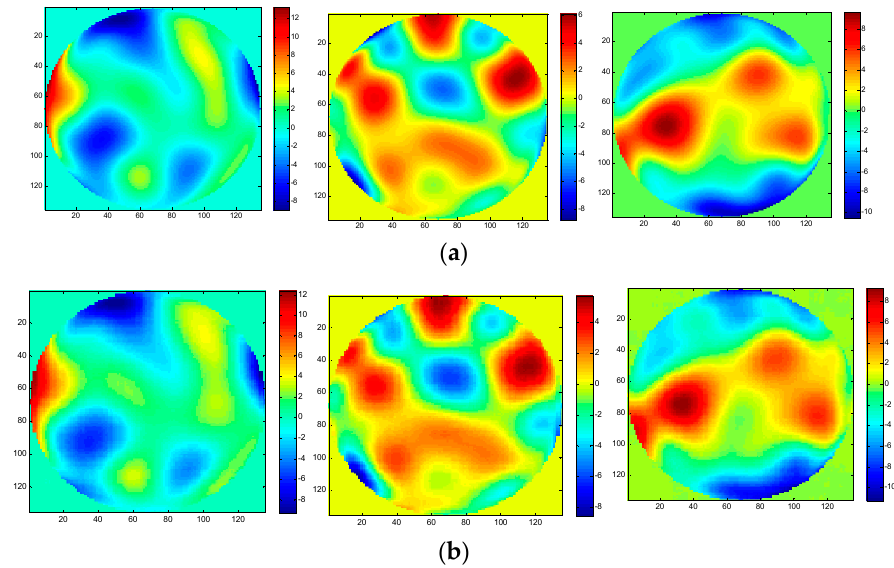
Figure 9. Phase maps of ( a ) the initial wavefront; ( b ) the wavefront by the De-VGG predicted for D/ r 0 = 20.